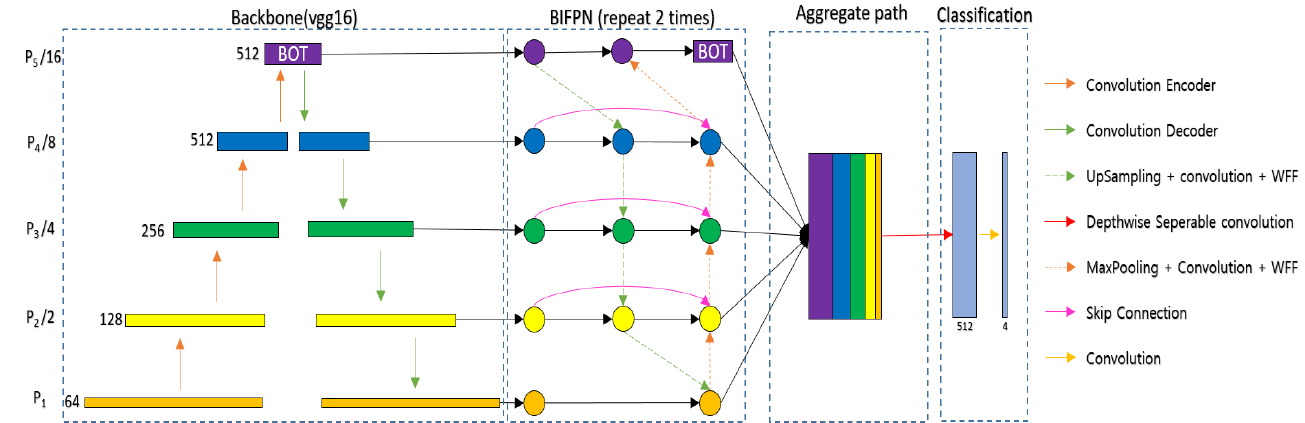
Figure 2. Schematic diagram of the proposed network